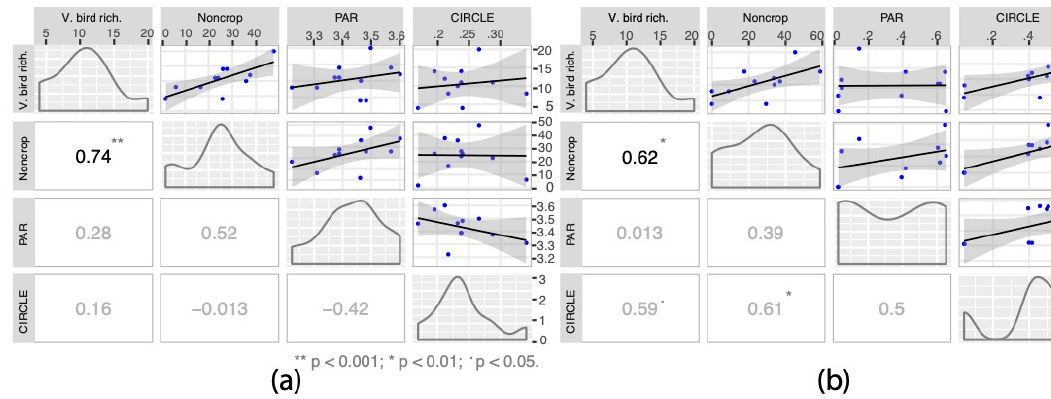
Figure 8. Correlations, data distributions, and scatterplots between vocalizing bird richness and landscape indicators, illustrating greater correlation for the noncrop indicator and cross-correlation of other indicators using both ( a ) UAS and ( b ) PlanetScope (PS) land cover data with outlier BKG removed (N = 11). Density plots are in the diagonal positions. Scatterplots on the upper right side include the black line fitted with a linear model gray shading as 95% confidence intervals. Labels are: V. bird rich.—vocalizing bird richness; Noncrop—proportion (%) of noncrop vegetation; PAR—perimeter area ratio; CIRCLE—circumscribing circle index.